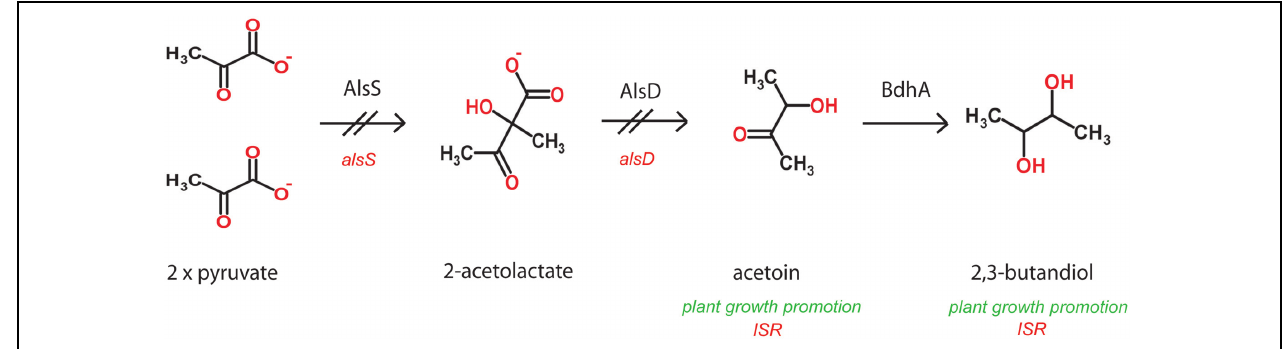
FIGURE 4 | Anaerobic and aerobic formation of 2,3-butanediol via acetoin involves acetolactate synthase and decarboxylase encoded by the alsSD operon. The alsS insertion mutation abolishes synthesis of 2,3-butandiol (Renna et al., 1993; Cruz Ramos et al., 2000).